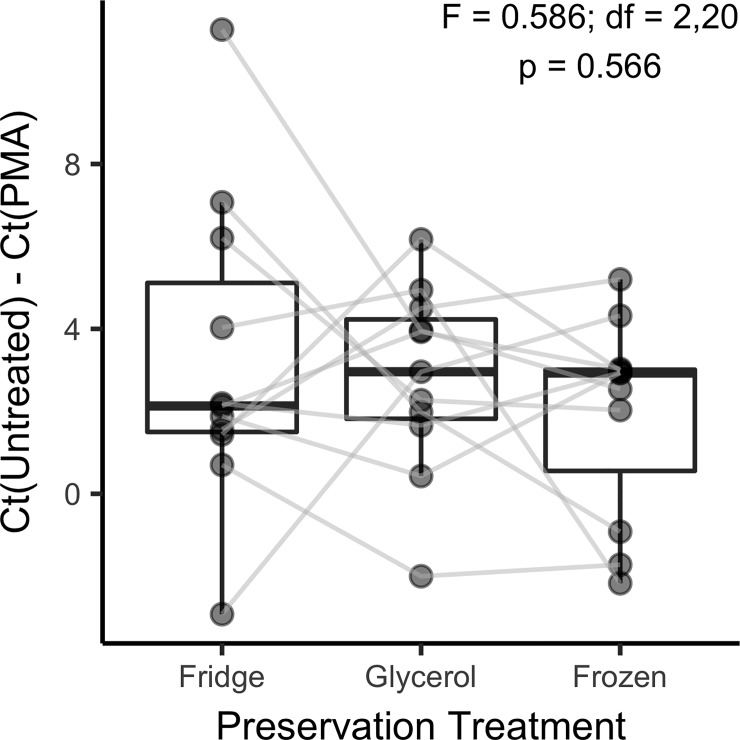
Cell viability was not reduced by freezing.Analysis of the effect of preservation treatments on cell viability from slough from 11 patients assessed by PMA-qPCR. The difference in non-treated and PMA-treated samples are displayed on the y-axis and gray lines connect measurements taken from the same patient wound.